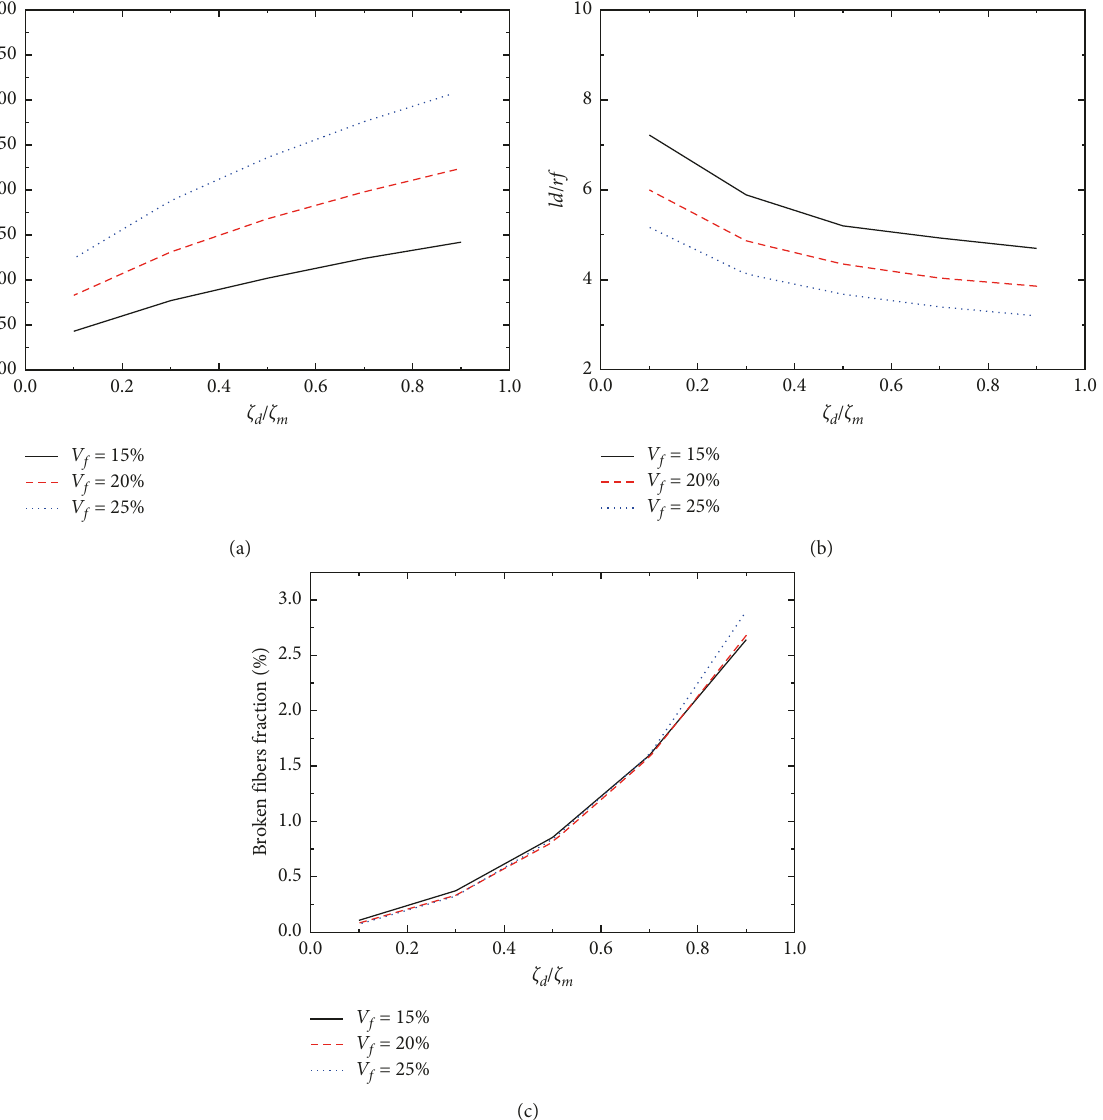
Figure 2: (a) The first matrix cracking stress versus the interface debonding energy curves; (b) the interface debonding length versus the interface debonding energy curves; (c) the broken fibers fraction versus the interface debonding energy curves for different fiber